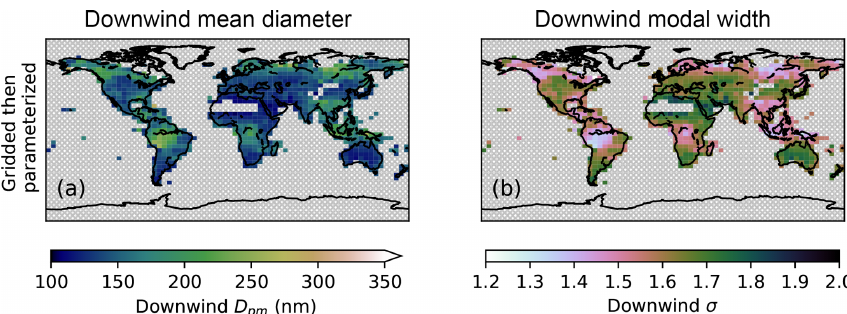
Figure 1. Annual-mean median diameter (a) and modal width (b) for sub-grid-processed biomass burning emissions predicted for 2010 using the Sakamoto et al. (2016) parameterization after 24h of sub-grid coagulation with an emitted median diameter of 100nm and an emitted modal width of 2. Fire (FINNv1.5) and meteorological data are averaged over a 4 ◦ × 5 ◦ grid, and then the gridded data are run through the Sakamoto et al. (2016) parameterization. The regions with grey crosshatching are grid cells with no fire